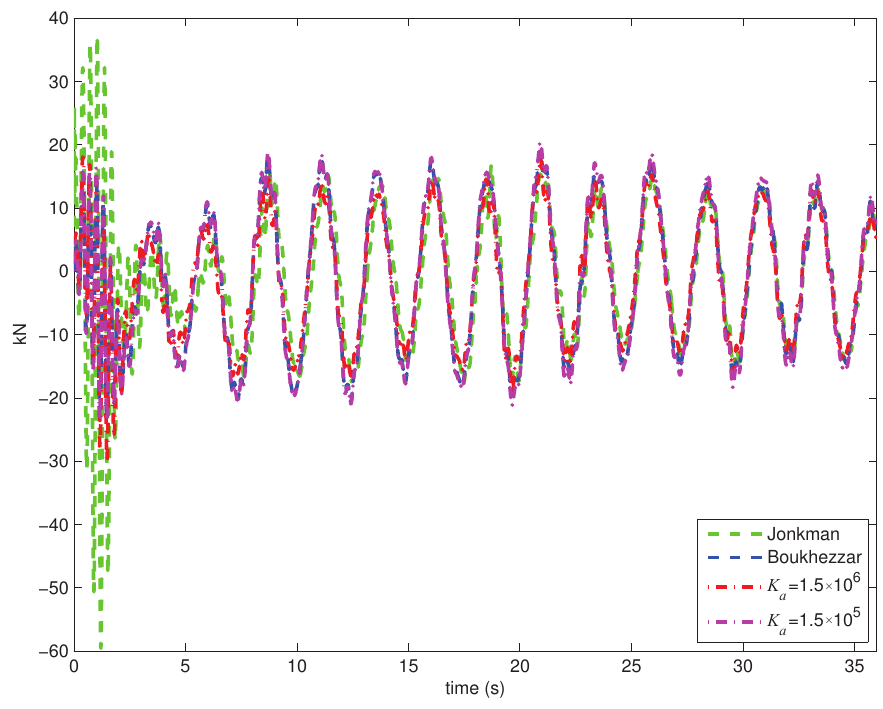
Figure 11. Tower top/yaw bearing side-to-side shear force.